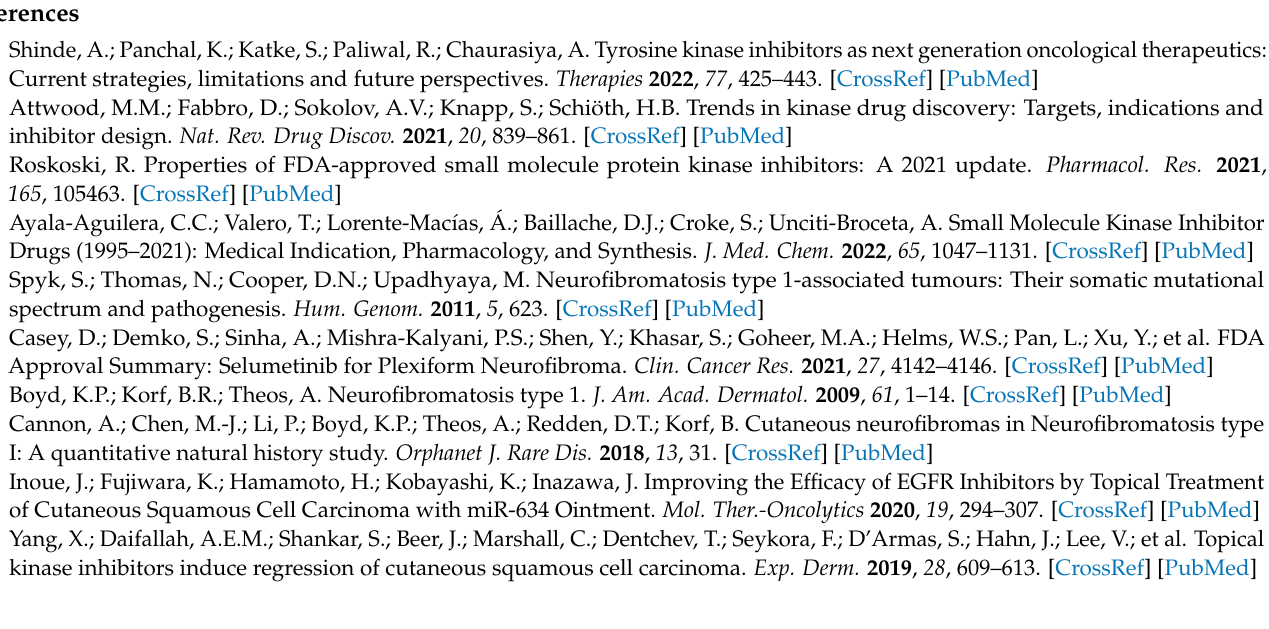
Figure S6: UV/visible spectra of selumetinib (final concentration = 6.25 µ g · mL − 1 ) at pH 3 (in red) and at pH 9 (in